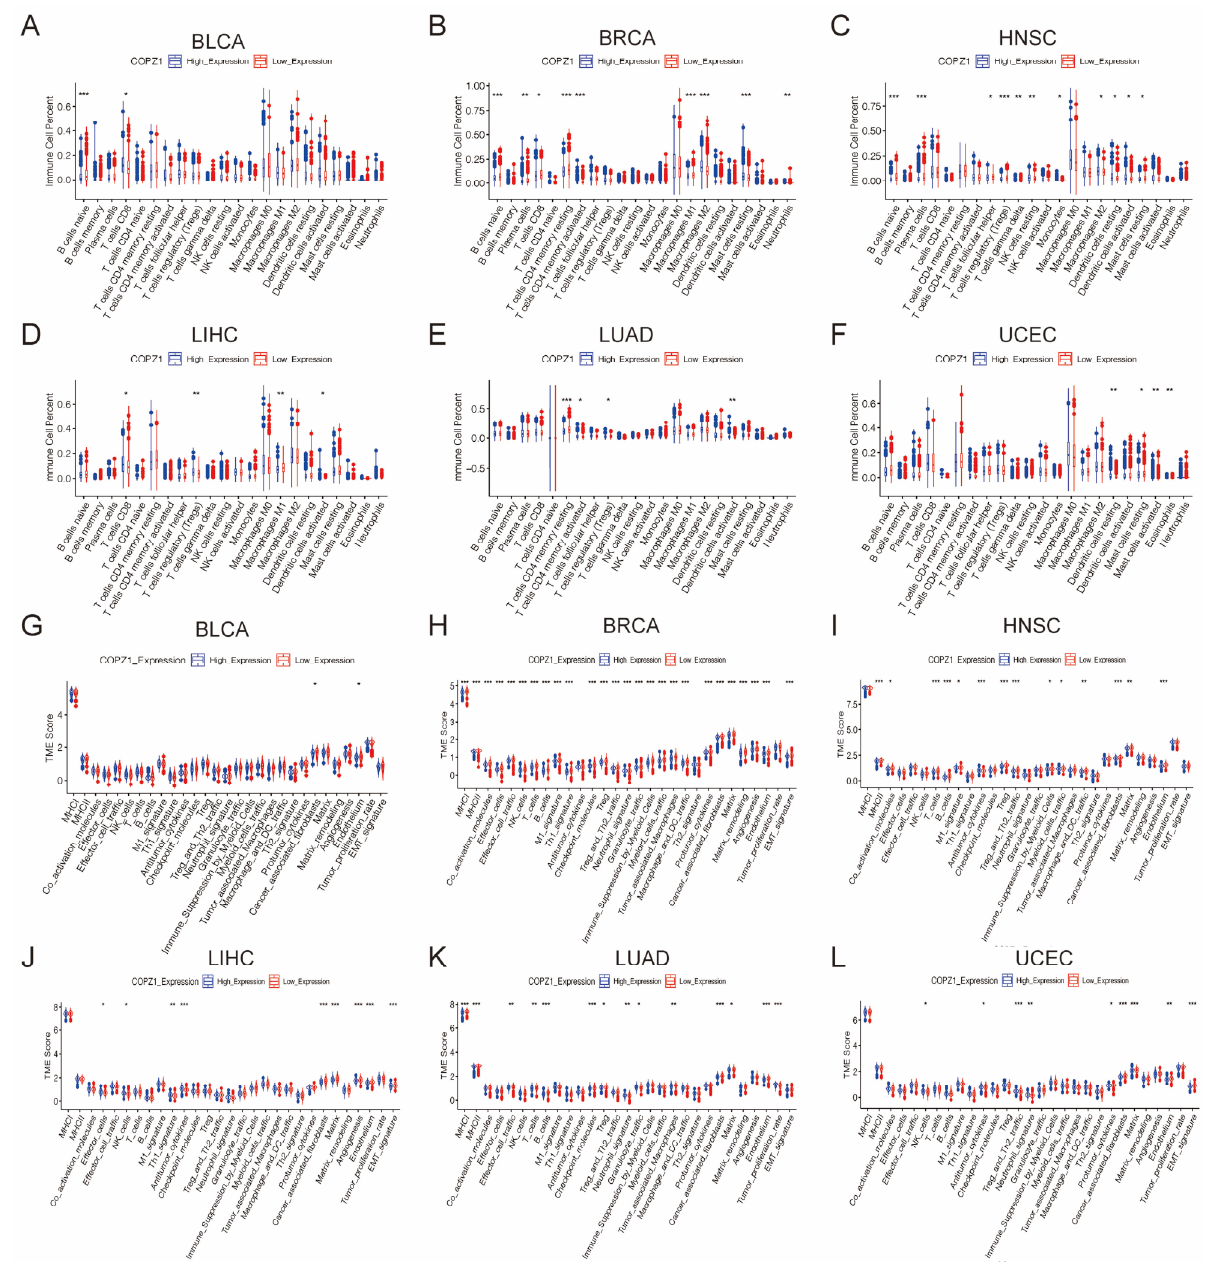
Figure 8. Correlation analysis between COPZ1 expression and tumor-infiltrating immune cells and tumor microenvironment score. ( A – F ) I Tumor-infiltrating immune cells between high and low COPZ1 expression groups in six types of cancer. ( G – L ) TME score between high and low COPZ1 expression groups in six types of cancer. The red box means high COPZ1 expression group, and the blue box means low COPZ1 expression group. * p <0.05, ** p <0.01, *** p <0.001.